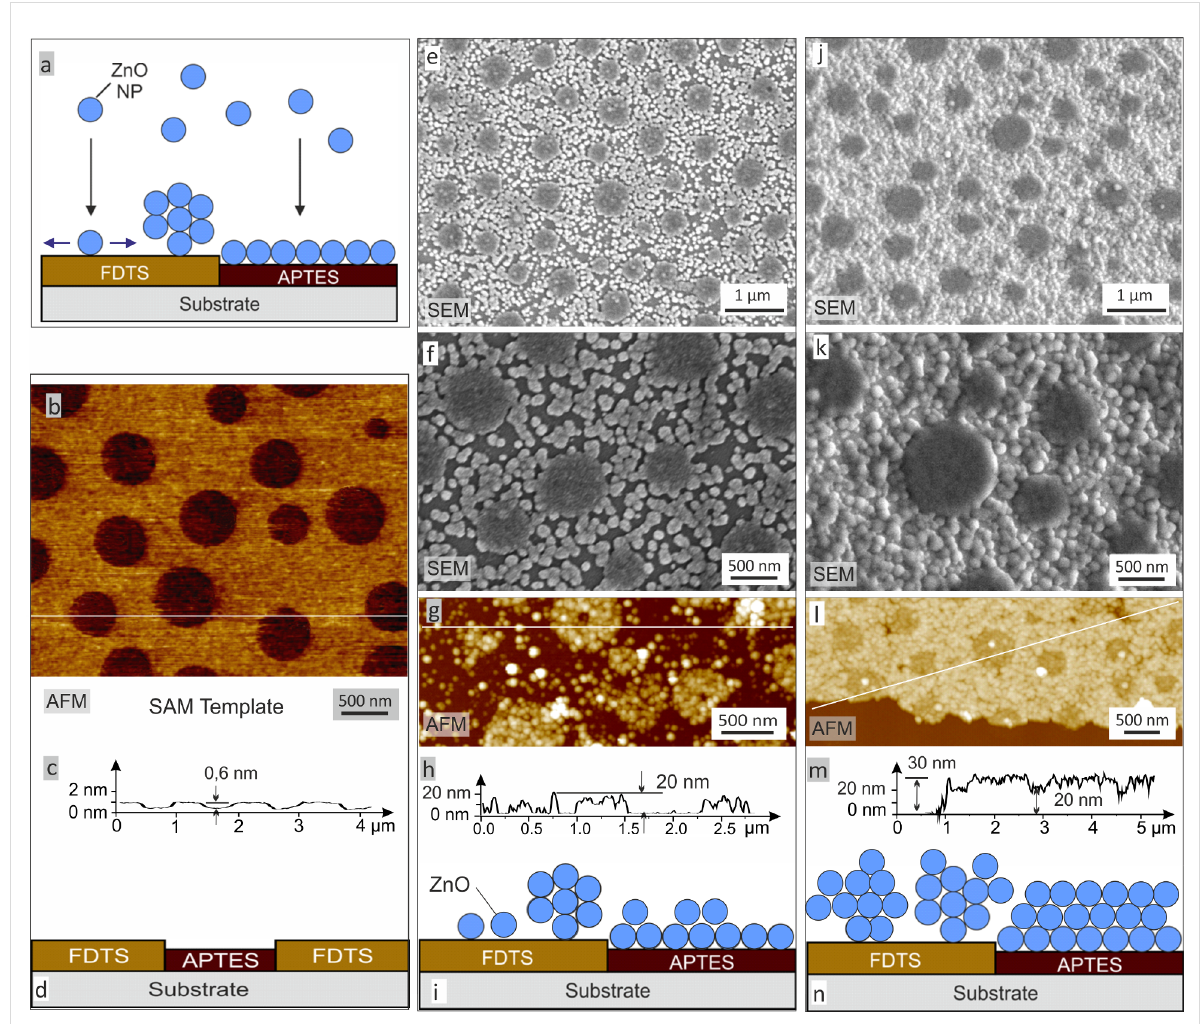
Figure 1: Self-assembly of ZnO-containing material on prepatterned substrates. (a) Schematic representation of the deposition mechanism. (b–d) The nonmineralized substrate shows the APTES islands (dark red) in the FDTS matrix (yellow). (e–i) SEM and AFM images show the deposited material on the templates. On the APTES, a smooth and compact film is formed, whereas on the FDTS agglomerates are deposited. With an increasing amount of deposited material, those agglomerates grow together (j–n) resulting in a rough surface for the final morphology.